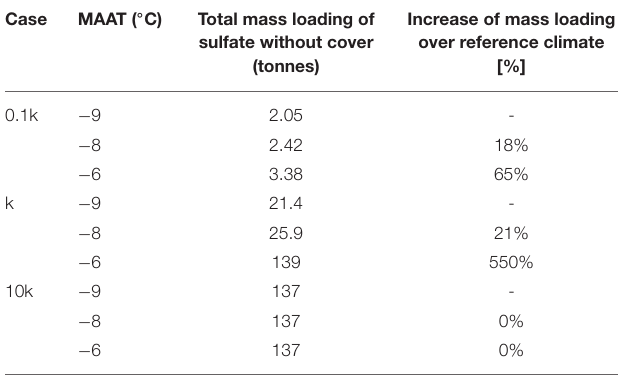
TABLE 4 | Performance analysis of cover effectiveness for all simulation cases ( k refers to k ref FeS 2